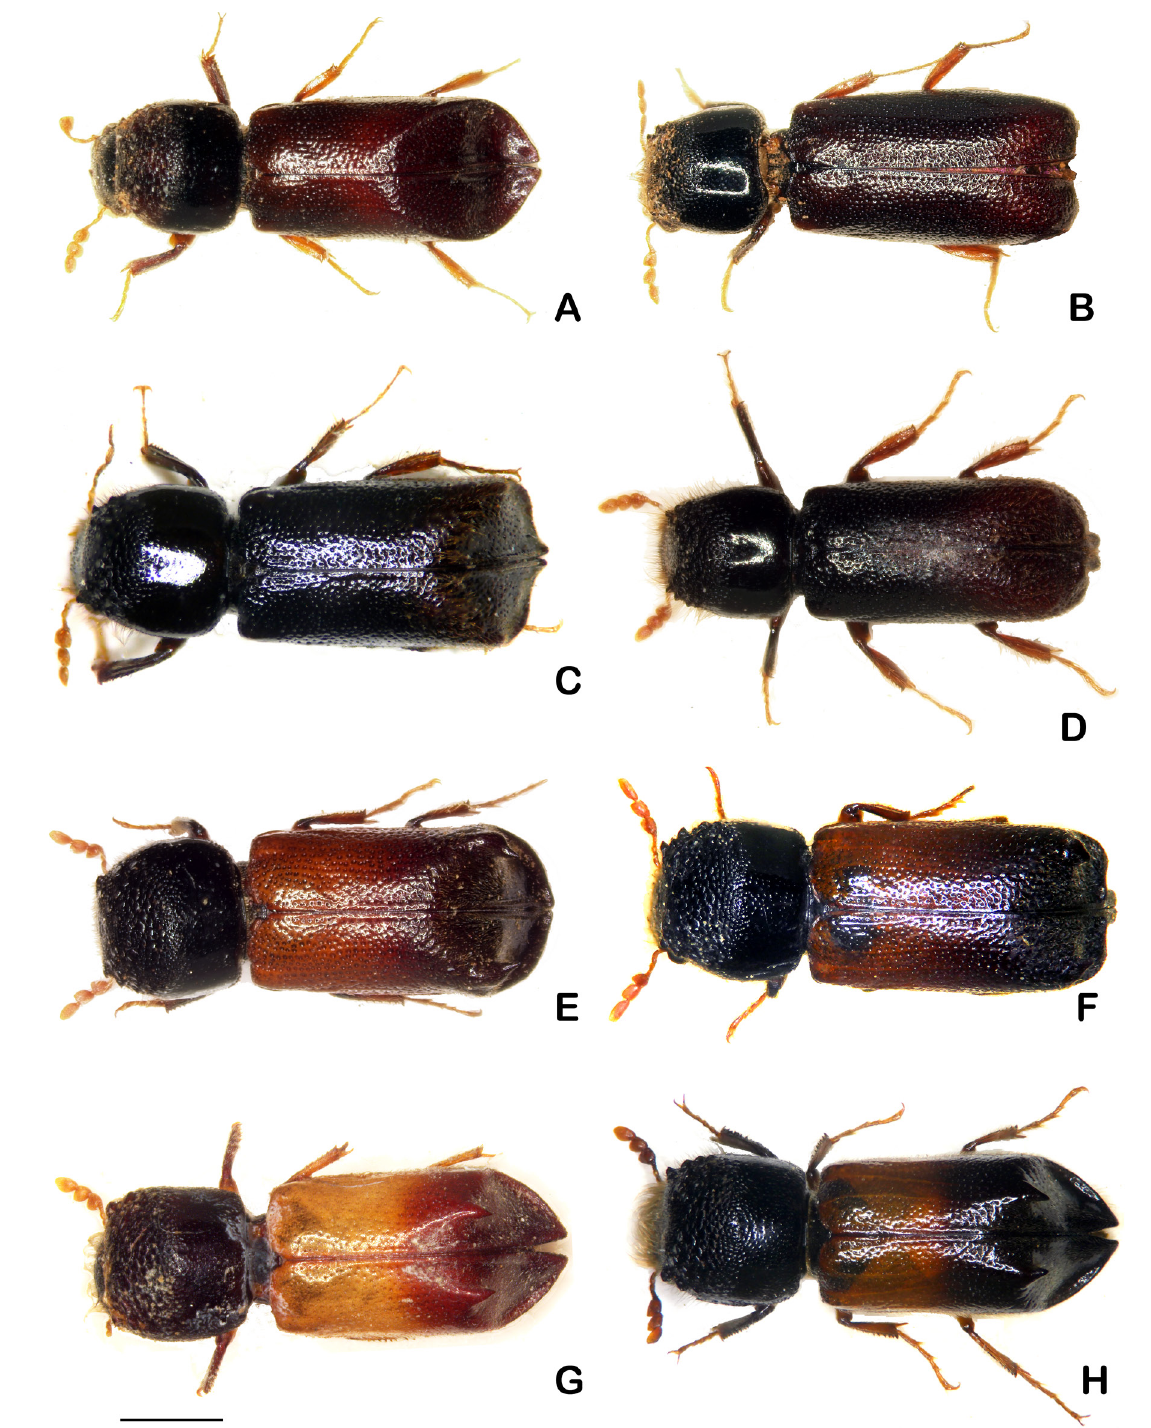
Fig. 1. Dorsal view of species of Xylopertha Guérin-Méneville, 1845. A . Xylopertha elegans sp. nov., ♂. B . X. elegans sp. nov., ♀. C . X. retusa (Olivier, 1790), ♂. D . X. retusa (Olivier, 1790), ♀. E . X. praeusta (Germar, 1817 ), ♂. F . X. praeusta (Germar, 1817), ♀. G . X. reflexicauda (Lesne, 1937), ♂. H . X. reflexicauda (Lesne, 1937), ♀. Scale bar = 1